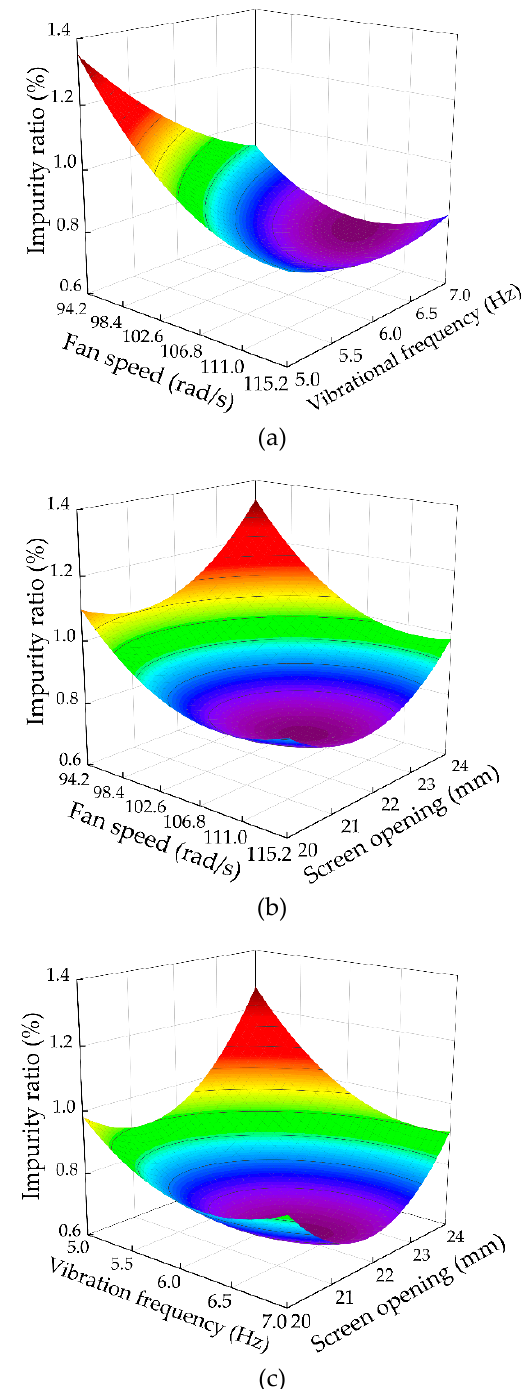
Figure 9. Response surface plots for interaction between the pairs ( a ) FS–VF, ( b ) FS–SO, and ( c ) VF–SO.